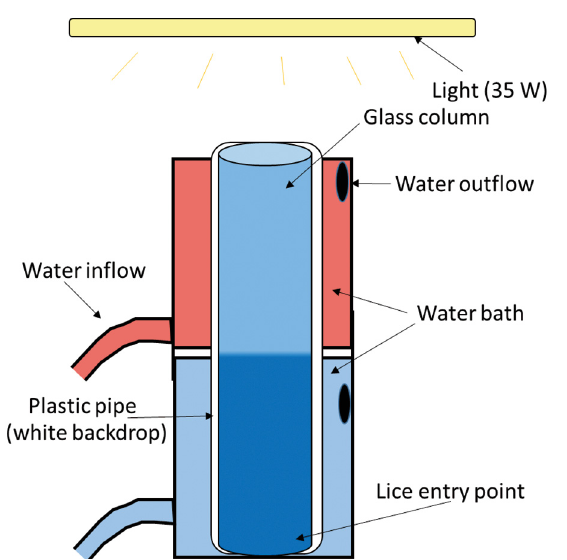
Fig. 1. Experimental column used to test the vertical distri- bution of nauplii and copepodid larvae in salinity